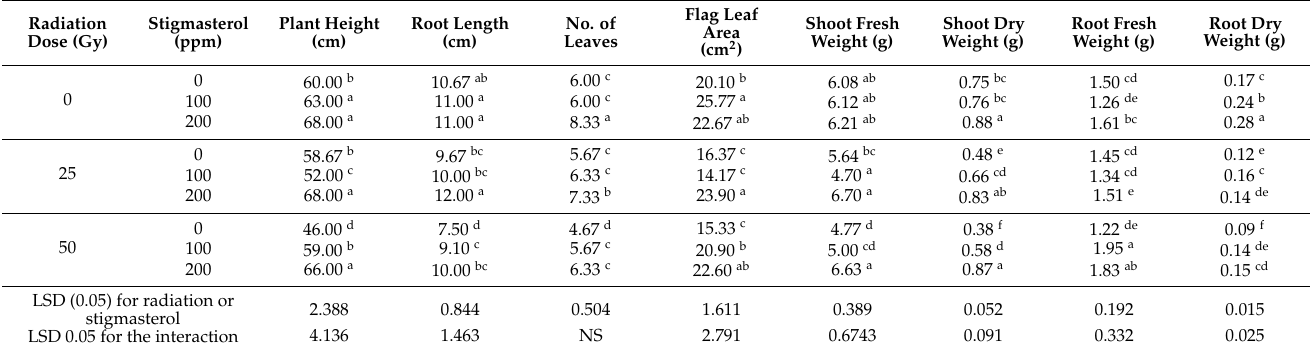
Table 1. Effect of stigmasterol treatments on the growth parameters of wheat plants grown from irradiated grains. The different letters (a–f) show statistical significance at p < 0.05. Differences are statistically significant at p < 0.05; vertical bars indicate ±